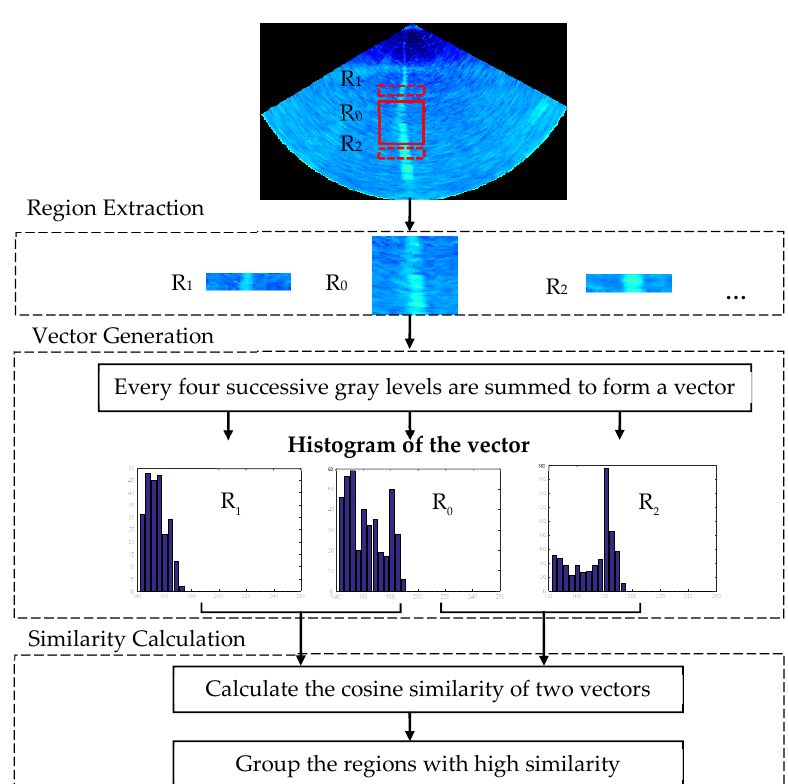
Figure 9. An overview of the target localization algorithm.